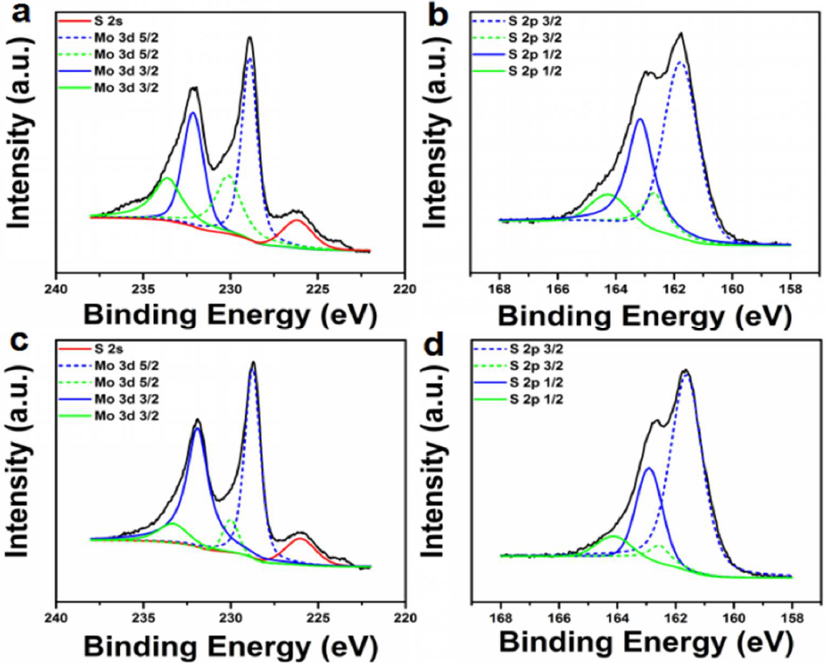
Figure 3. High resolution X-ray photoelectron spectroscopy (XPS) spectrum recorded for the Mo 3D of ( a ) ZT-MoS 2 and ( c ) P-MoS 2 , and S 2p of ( b ) ZT-MoS 2 ( d ) P-MoS 2 . The data were the average of three measurements.